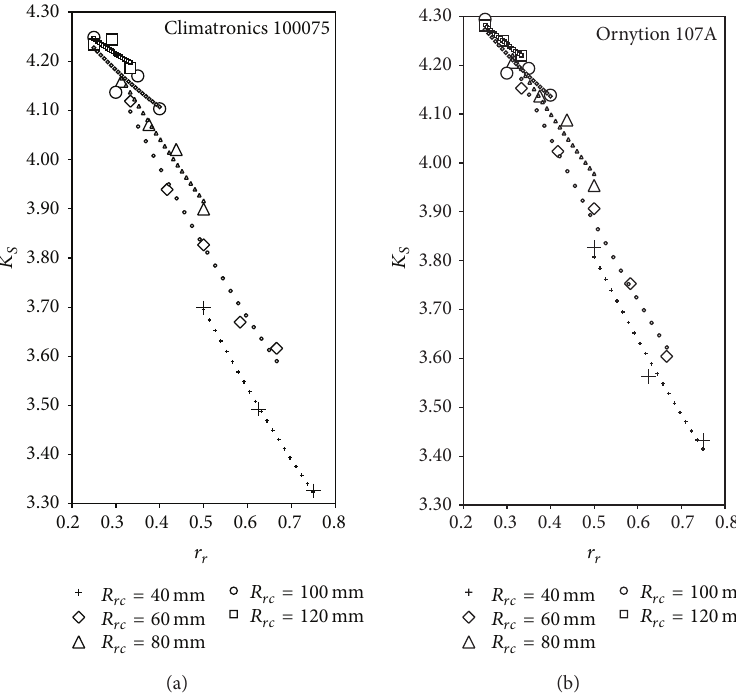
Figure 6: Anemometer factor, 𝐾 𝑆 , from the calibrations performed on the Climatronics 100075 and Ornytion 107A as a function of parameter 𝑟 𝑟 , for rotors with the same cup center rotation radius, the experimental results. See also Table 3.